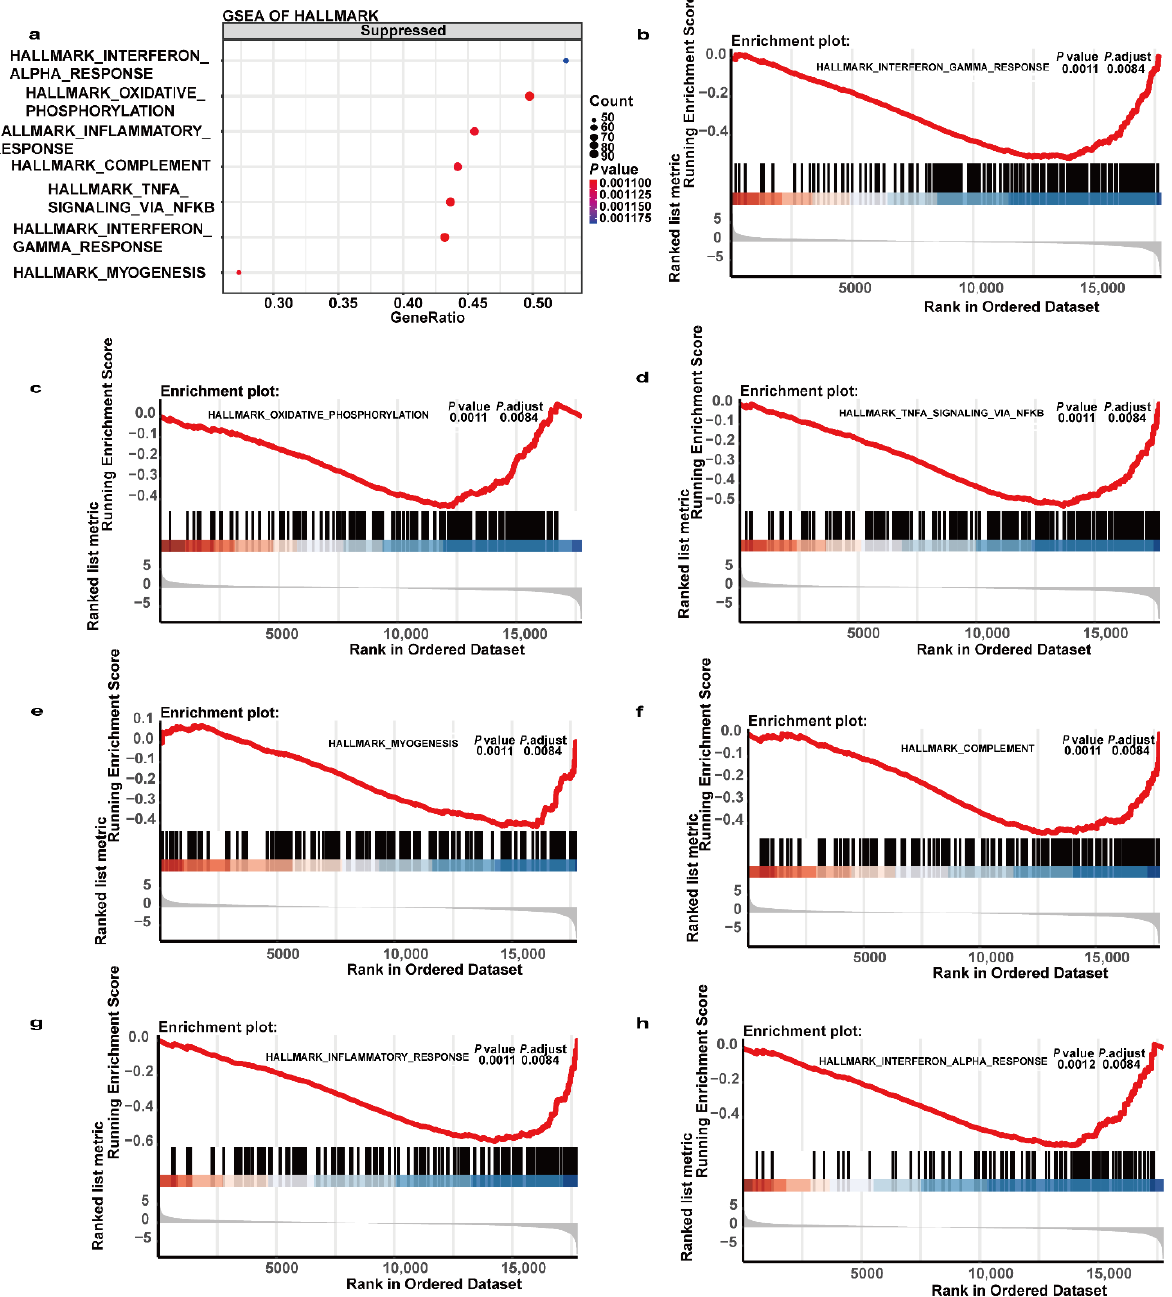
Figure 6. Gene sets enrichment analysis (GSEA) result of Sup-DLBCL patients compared to Sub-DLBCL patients. ( a ) GSEA analysis using hallmark gene sets was carried out. “Suppressed” indicates the pathways enriched in the Sup-DLBCL group. GSEA analysis showed that Sub-DLBCL was negatively associated with ( b ) interferon gamma response, ( c ) oxidative phosphorylation, ( d ) TNF-alpha signaling via NF-κB, ( e ) myogenesis, ( f ) complement, ( g ) inflammatory response and ( h ) interferon-alpha response.